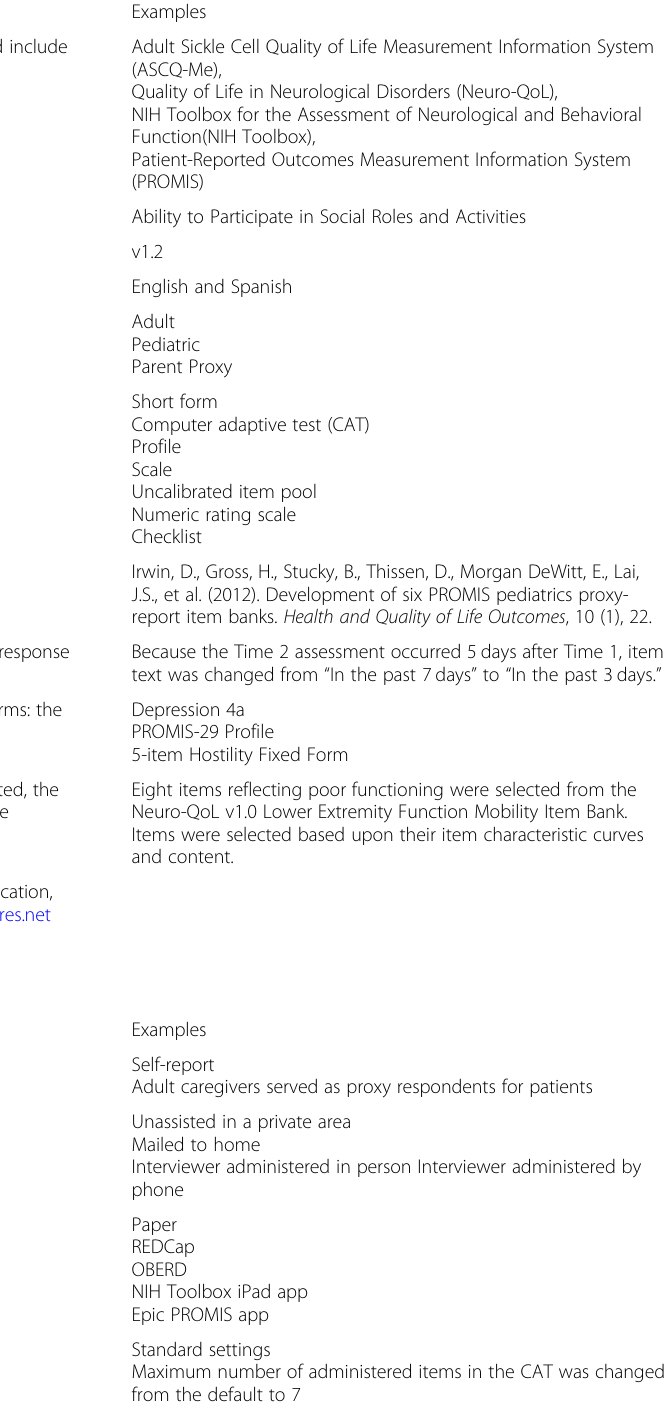
Table 1 Reporting checklist for ASCQ-Me, Neuro-QoL, NIH Toolbox Emotion, and PROMIS Measure